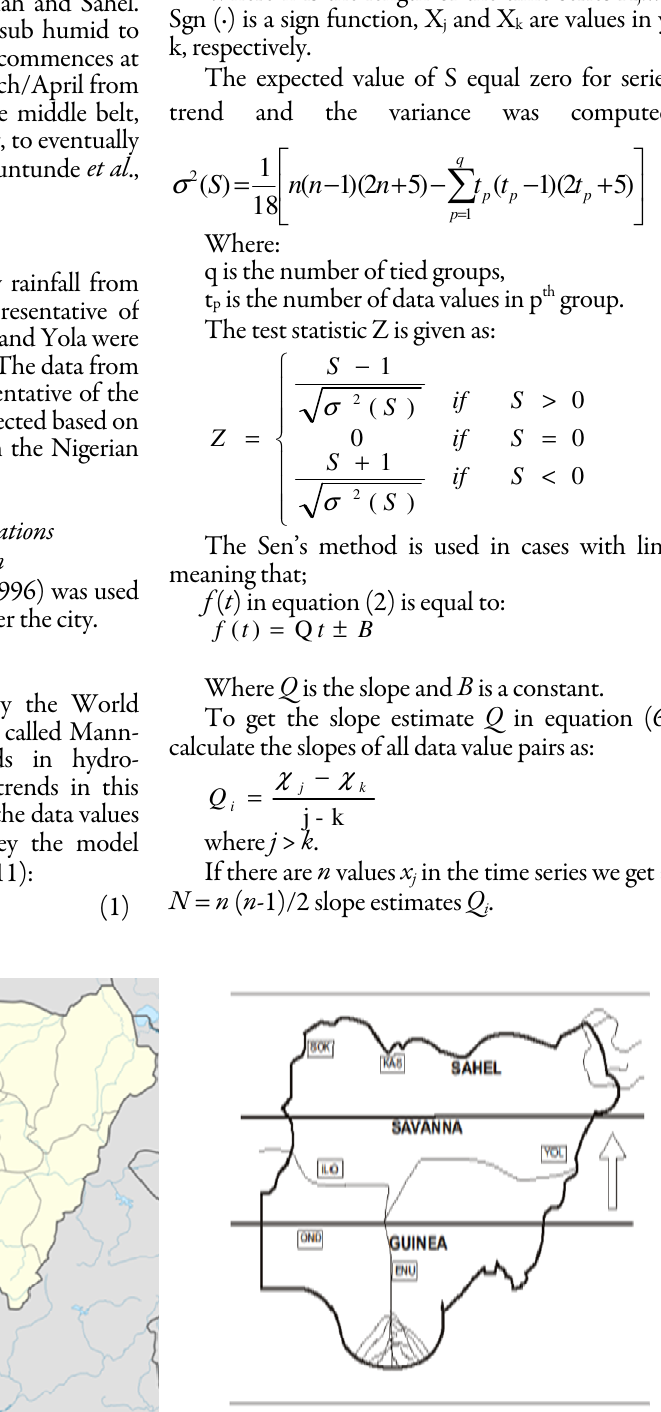
Fig. 1. The ecological zones of